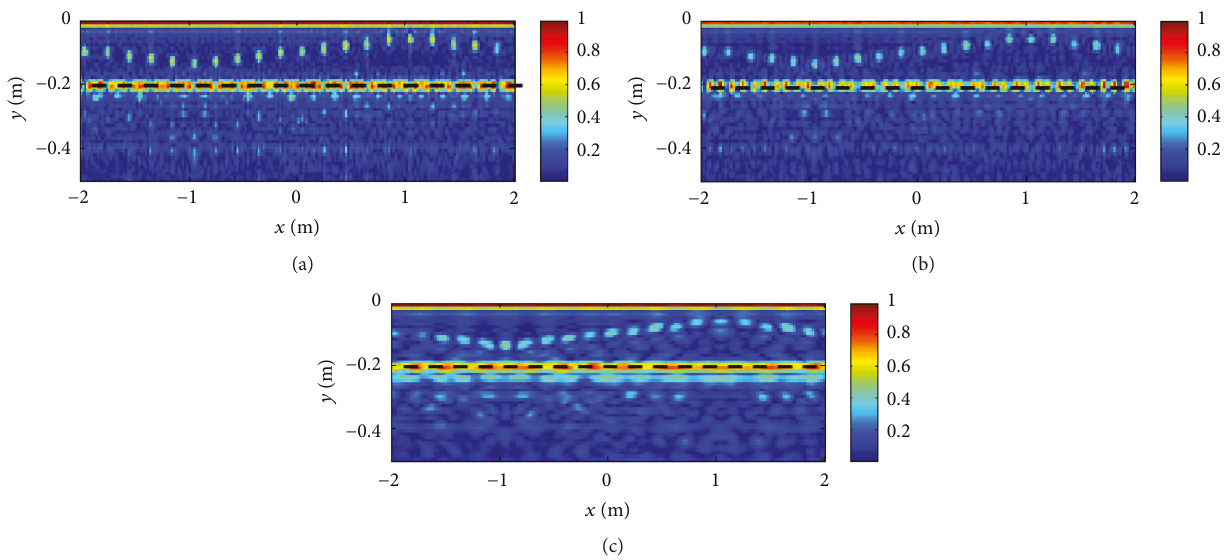
Figure 3: Imaging results with di ff erent step sizes. (a) Step size =2.5cm. (b) Step size =5cm. (c) Step size =10 cm.